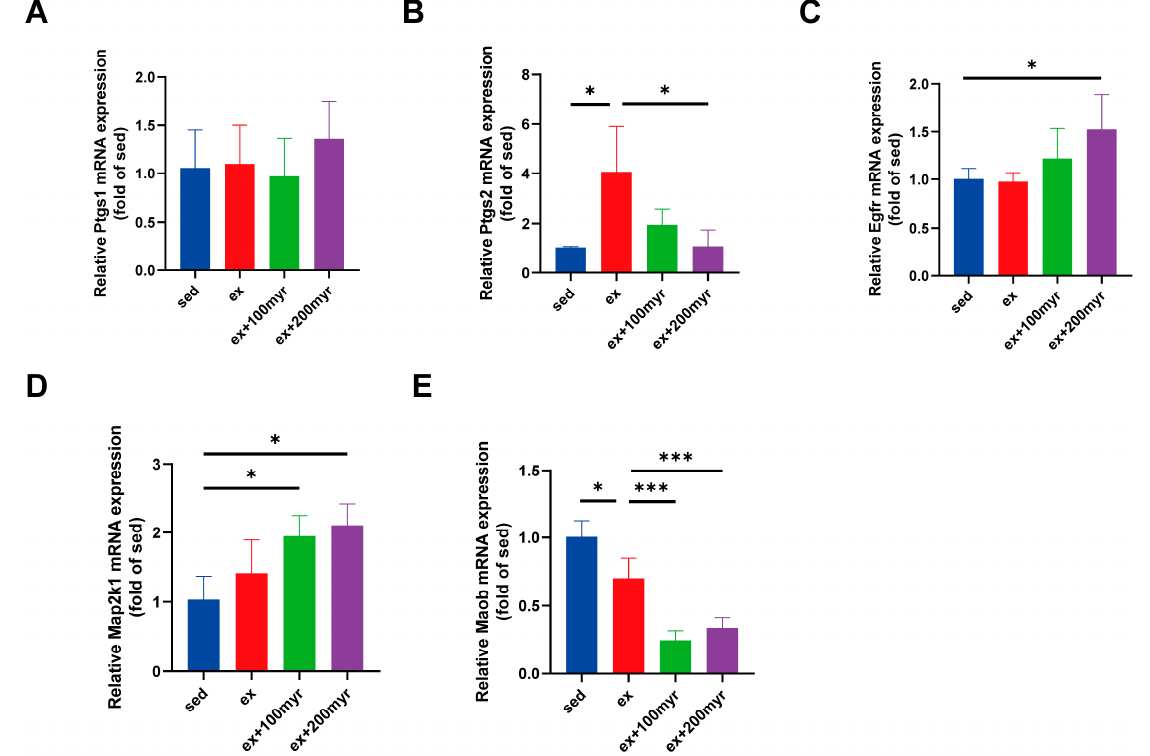
Figure 8. Transcriptional level of myricetin key targets. ( A ) Ptgs1; ( B ) Ptgs2; ( C ) Egfr; ( D ) Map2k1; and ( E ) Maob. The data are presented as mean ± SD. * p < 0.05; *** p < 0.001.